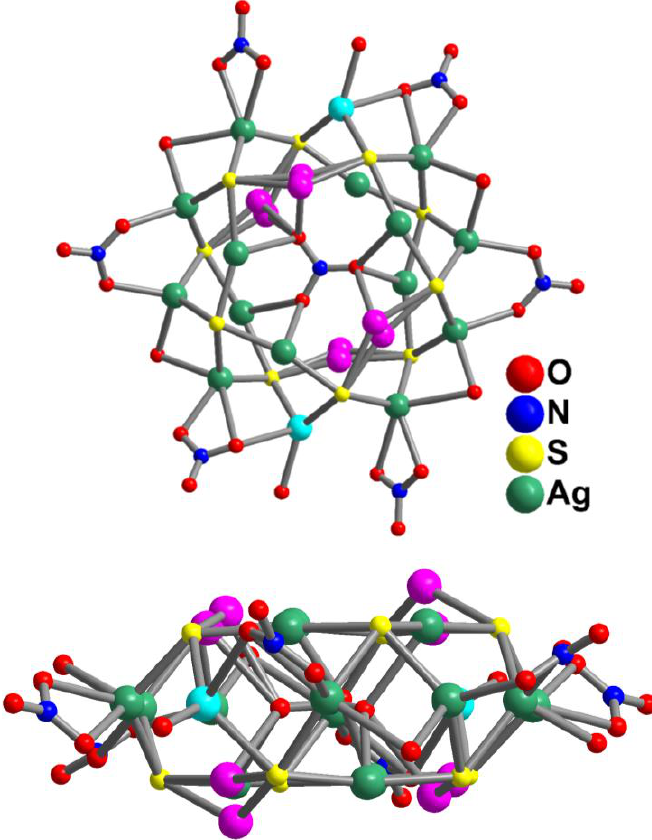
Figure 1. The structure of [NO 3 @Ag 19.2 (S t Bu) 10 (DMSO) 5.2 (NO 3 ) 9.2 ] in ball and stick model. Two capping NO 3 – and t Bu-groups are omitted for clarity. Pairs of disordered Ag atoms are colored in pink. Vacant Ag sites are colored in cyan.